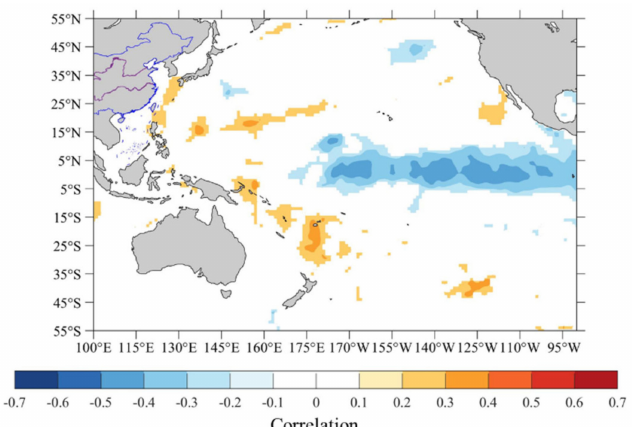
Figure 7. Spatial correlation between IMF1 and IMF2 average period and sea surface temperature during